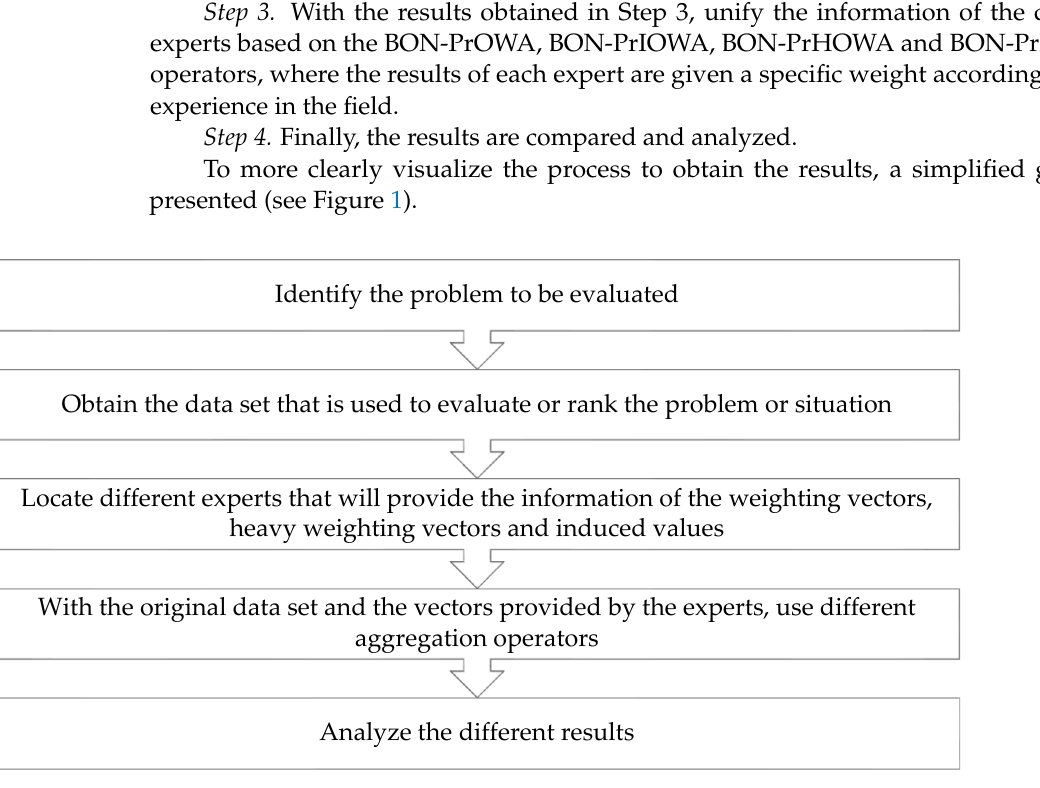
Figure 1. Flowchart of the steps to use the Bonferroni prioritized induced heavy ordered weighted average (BON-PIHOWA) operator.